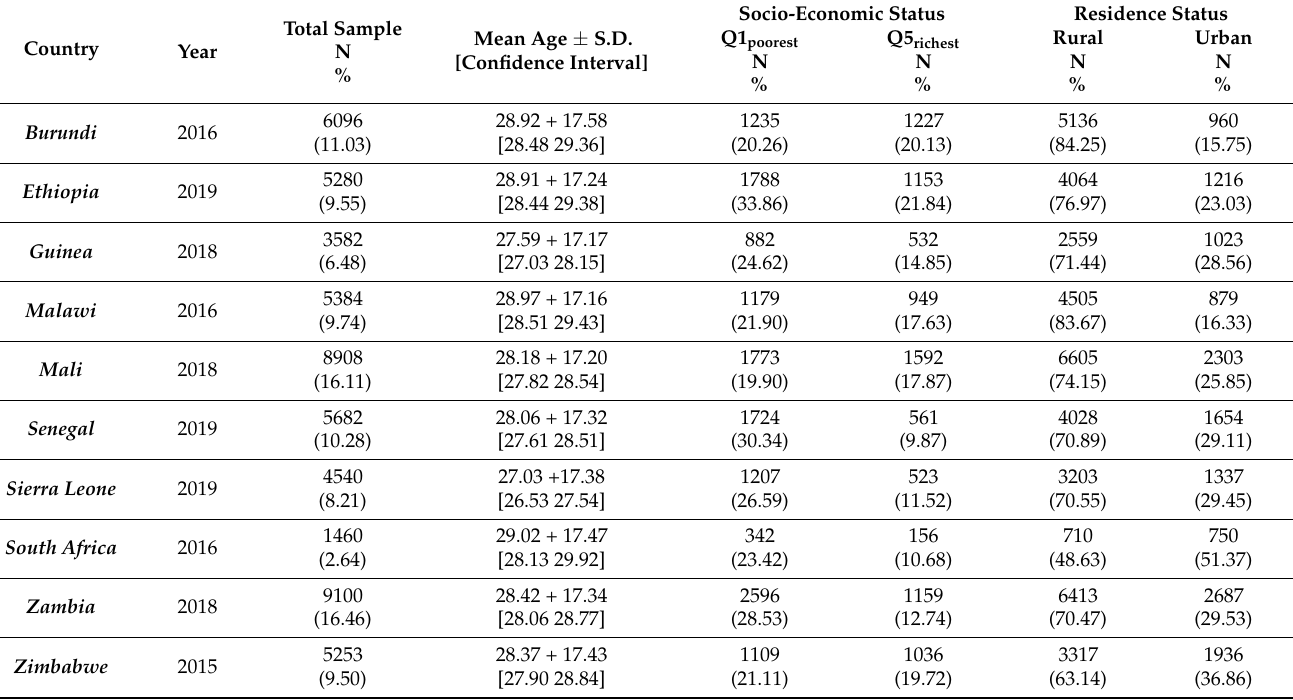
Table 1. Demographic characteristics by country (N = 55,285).